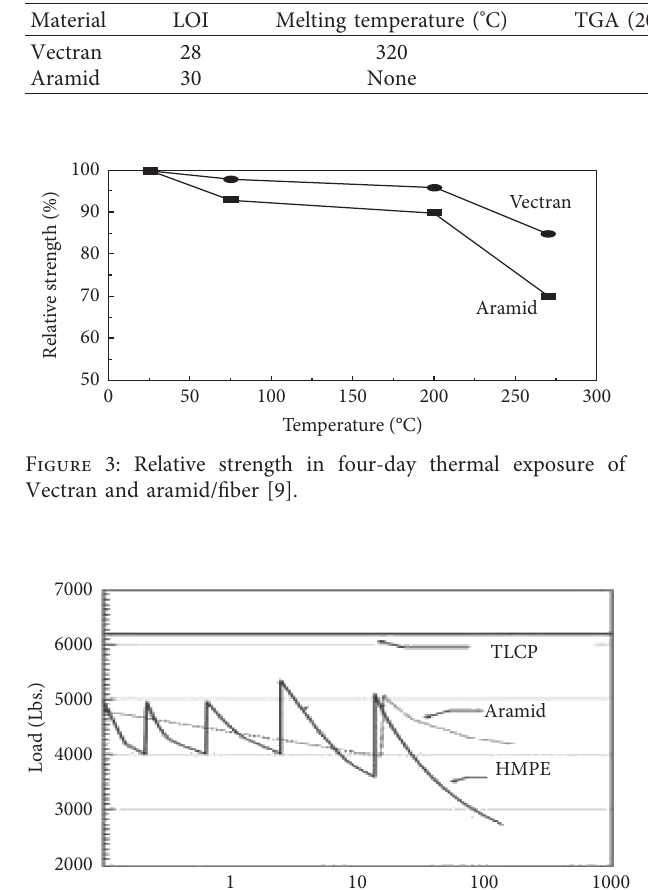
Table 3: Thermal nature of aramid and Vectran high-performance fiber [9].